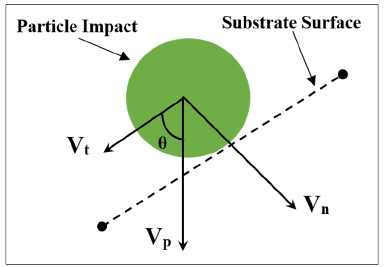
Figure 8. Decomposition of particle impact velocity at spray angle θ [41].